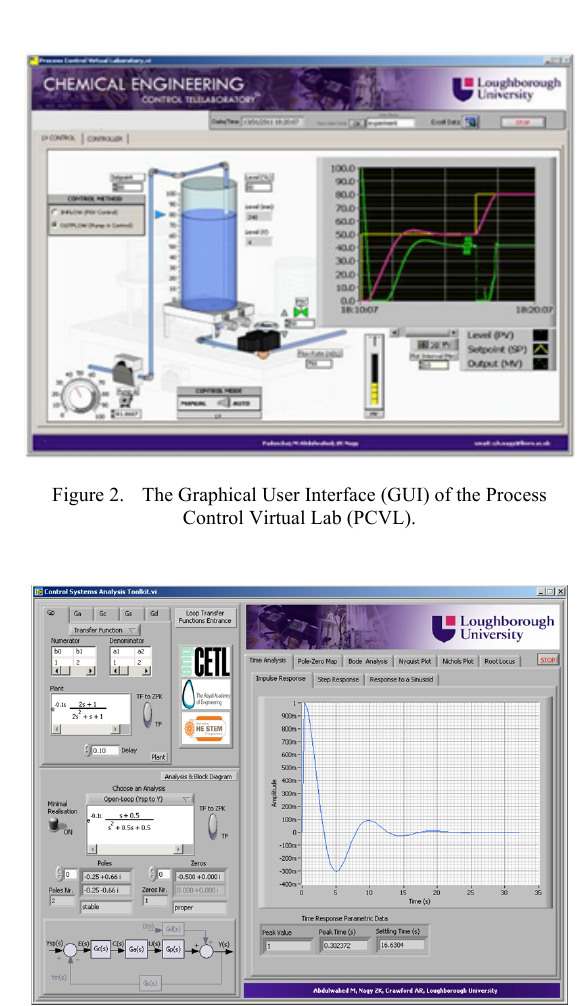
Figure 1. Simulink “Exercise 1” video tutorial developed with Camtasia; a frame with a number of assistive callouts